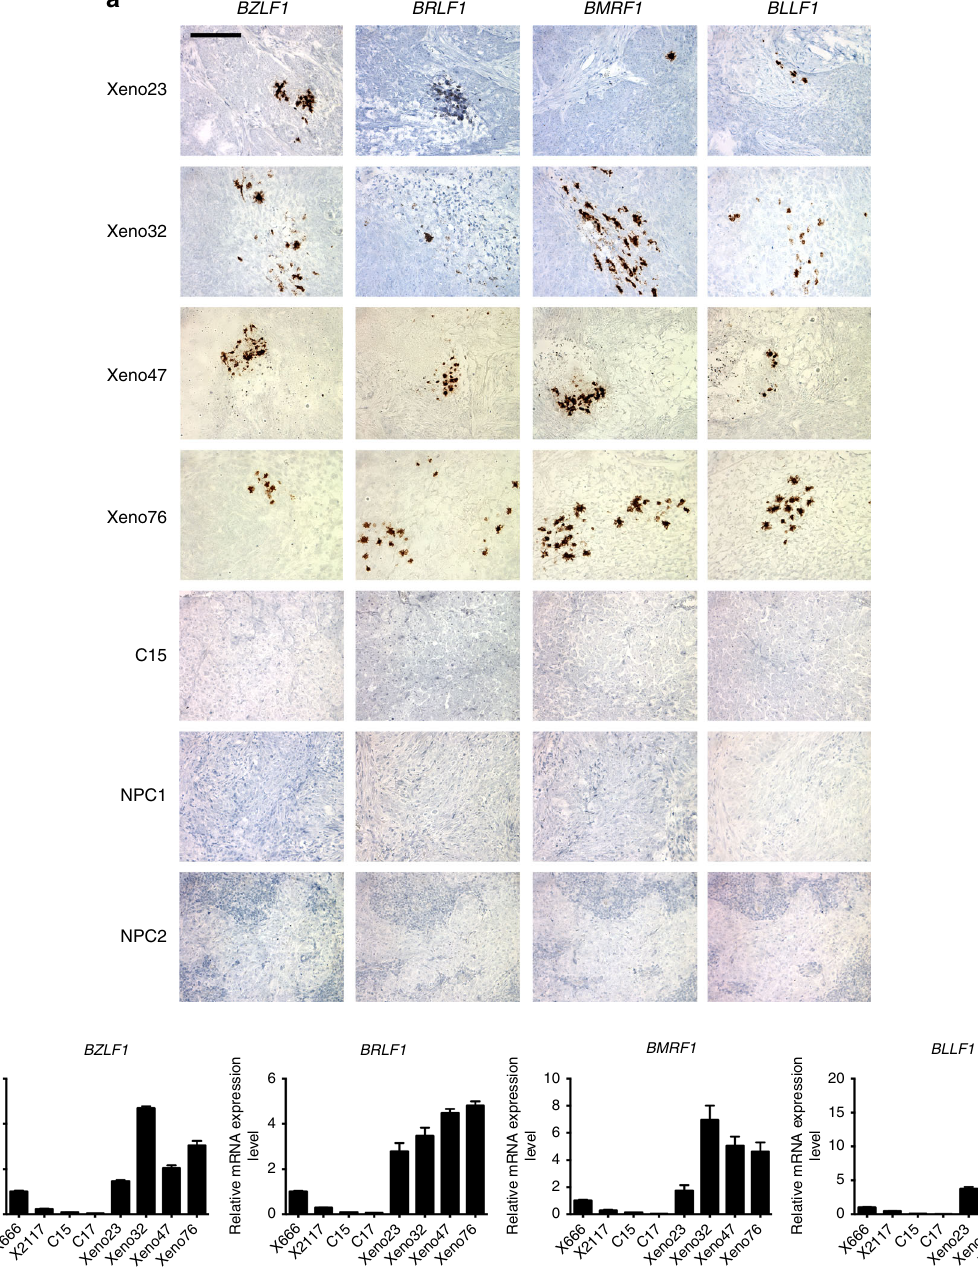
Fig. 2 Expression of lytic EBV genes in NPC PDXs. a The expression of BZLF1 , BRLF1 , BMRF1 and BLLF1 transcripts was determined by RNAscope ® in situ hybridization. Positive signals are shown as brown dots. Clusters of hybridization signals over NPC cells were interpreted as cells undergoing active lytic EBV infection. Abundant expression of lytic EBV genes was found in all newly established PDXs, but not in C15 or human NPC specimens (NPC1 and NPC2). Scale bar, 100 μ m. b Expression of EBV lytic genes in four long-term passaged and four newly established NPC PDXs (Xeno23, 32, 47 and 76) quanti fi ed by real-time PCR. The newly established PDXs exhibited higher levels of lytic gene expression. Data are shown as mean ± SD from three independent episomes during its propagation. Average EBV copy number of NPC43 was examined at different passages by real-time PCR. A gradual decrease of average EBV copy number of NPC43 was observed during propagation at early passages (from 100 copies at PD 5 to 34 copies at PD 22). It became relatively stable after PD 26, with 15 – 20 copies per cell, and eventually stabilized as ~10 copies per cell after PD 100 (Fig. 4a). FISH analysis also con fi rmed the dynamic pro fi le of EBV copy numbers in NPC43 cells at early and late subcultures (Supplementary Fig. 5). numbers were also observed in NPC43 treated with higher